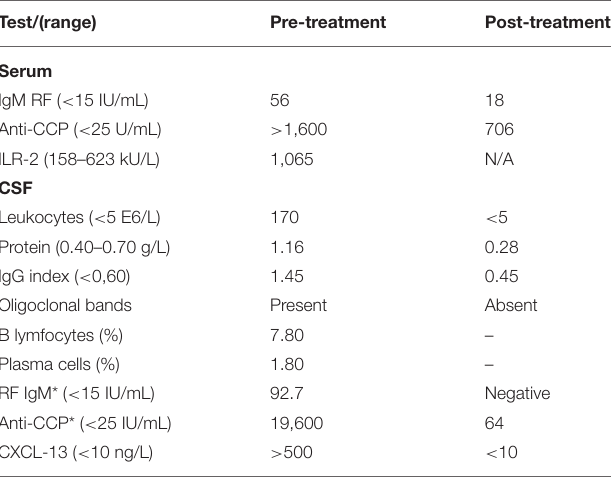
TABLE 1 | Serum and CSF markers before and after treatment.